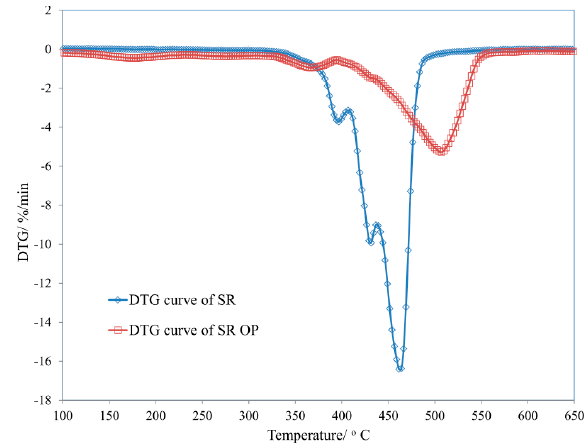
Figure 4. DTG curves of uncured (SR) and cured (SR OP) silicone rubber.